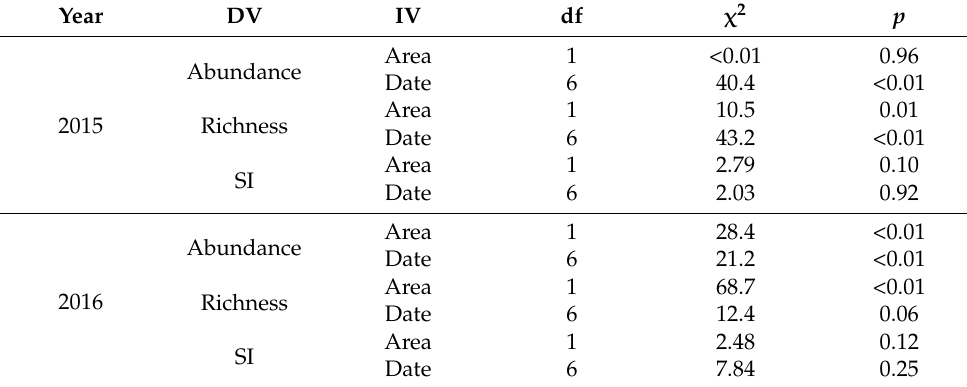
Table 2. Summary Statistics for the Models Developed to Assess the Effect of the Area (Olive Grove vs. Adjacent Shrubland Area) and the Week of Sampling on the Diversity of Families of Coleoptera in the Mirandela Region (Northeast Portugal) in 2015 and 2016. DV: Dependent Variable. IV: Independent Variable. SI: Simpson Index. df: Degrees of